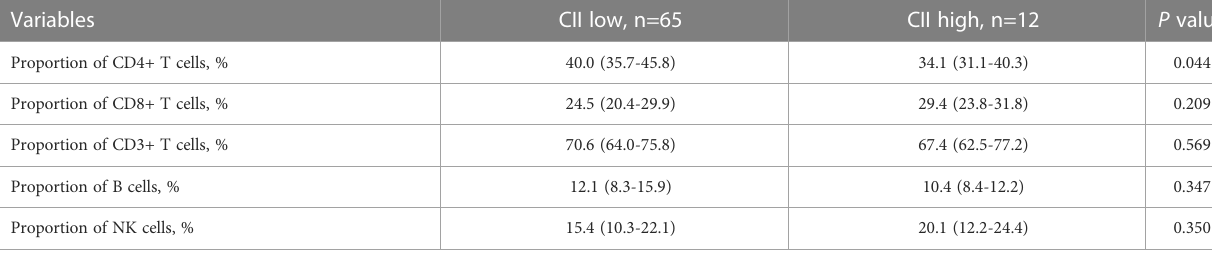
TABLE 4 Lymphocyte subsets according to CII in the pooled cohort. Variables